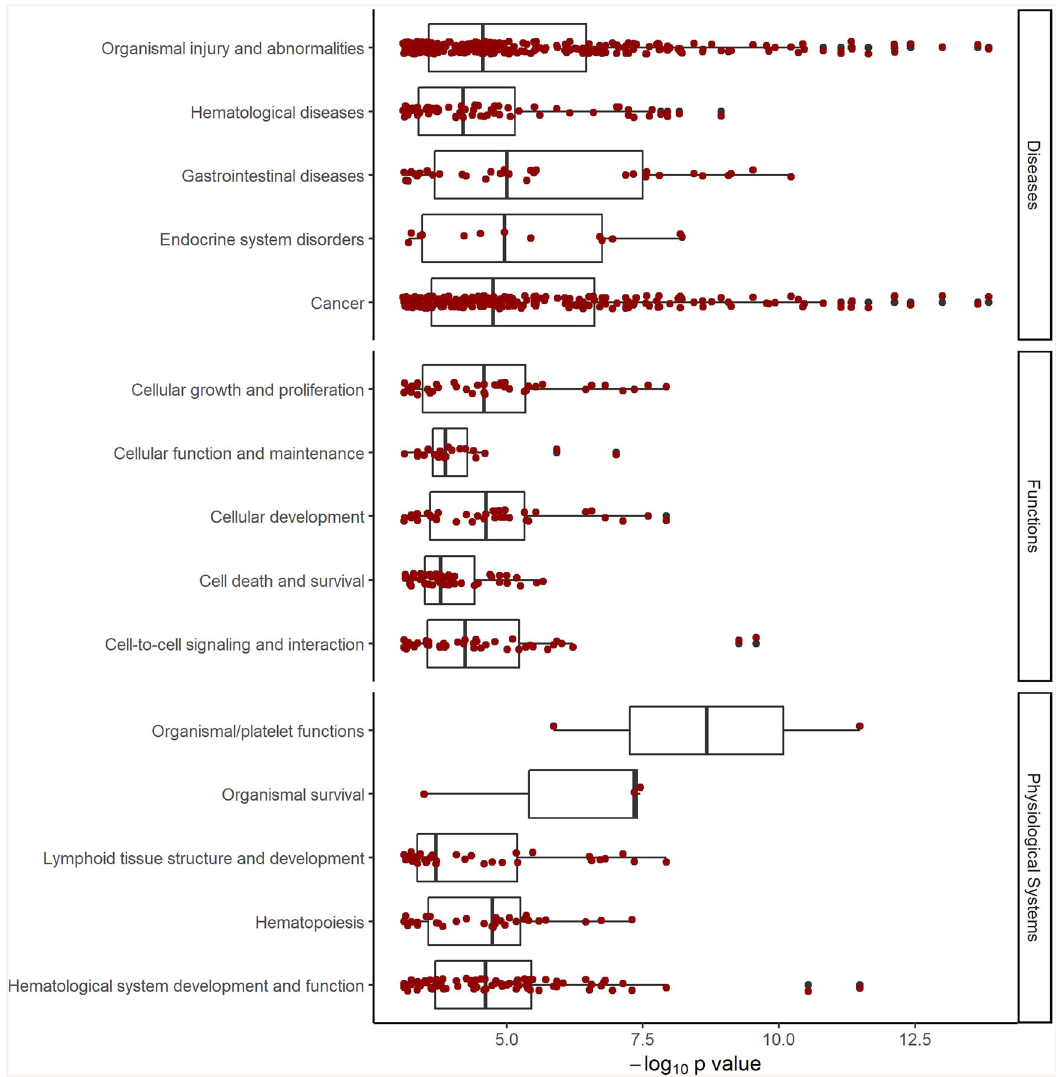
Fig. 4 Association with diseases, molecular functions, and physiologic systems. The 284 candidate causal PLT genes (Supplementary Data 16) were analyzed for association with diseases, molecular functions, and physiologic systems, using the Ingenuity Pathway Analysis (see “ Methods ” ). Shown are P values of the identi fi ed associations along with median and interquartile ranges for each group (boxplots). Dark red dots represent individual associations, and black dots indicate outliers. For details on associations, see Supplementary Data